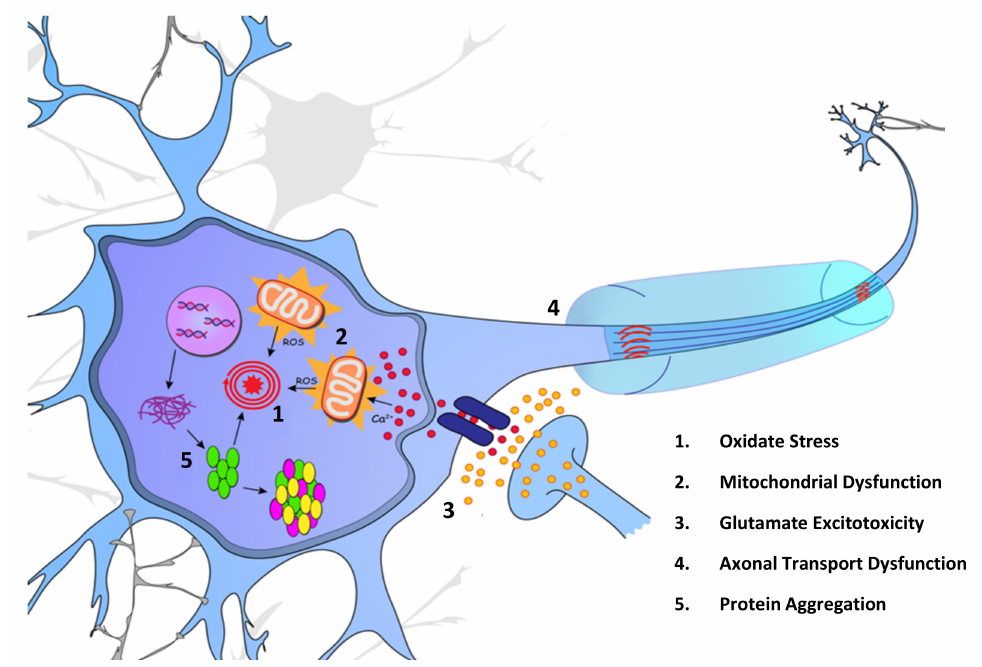
Figure 1. Proposed intracellular pathogenic mechanisms of ALS. (1) Oxidative stress caused by a multitude of factors, is believed to progress disease pathology in ALS patients due to the harmful side-effects of ROS build-up. (2) Build-up of reactive oxygen species (ROS) from the dysregulation of mitochondrial function has been proposed as an initiating factor for ALS. Multiple ALS-linked proteins interact with cellular mitochondria, including SOD1 , TDP-43, and FUS . (3) Overstimulation of glutamate receptors has been proposed as a mechanism for ALS disease pathogenesis and is the disease pathway targeted by the first approved ALS therapy, riluzole. (4) Impaired axonal transport has been implicated in ALS disease pathology, with the presence of protein aggregations inhibiting functional transport along microtubules. (5) With the impairment of proteostasis, proteins such as SOD1 and TDP-43 accumulate within the cytoplasm, further impeding cell